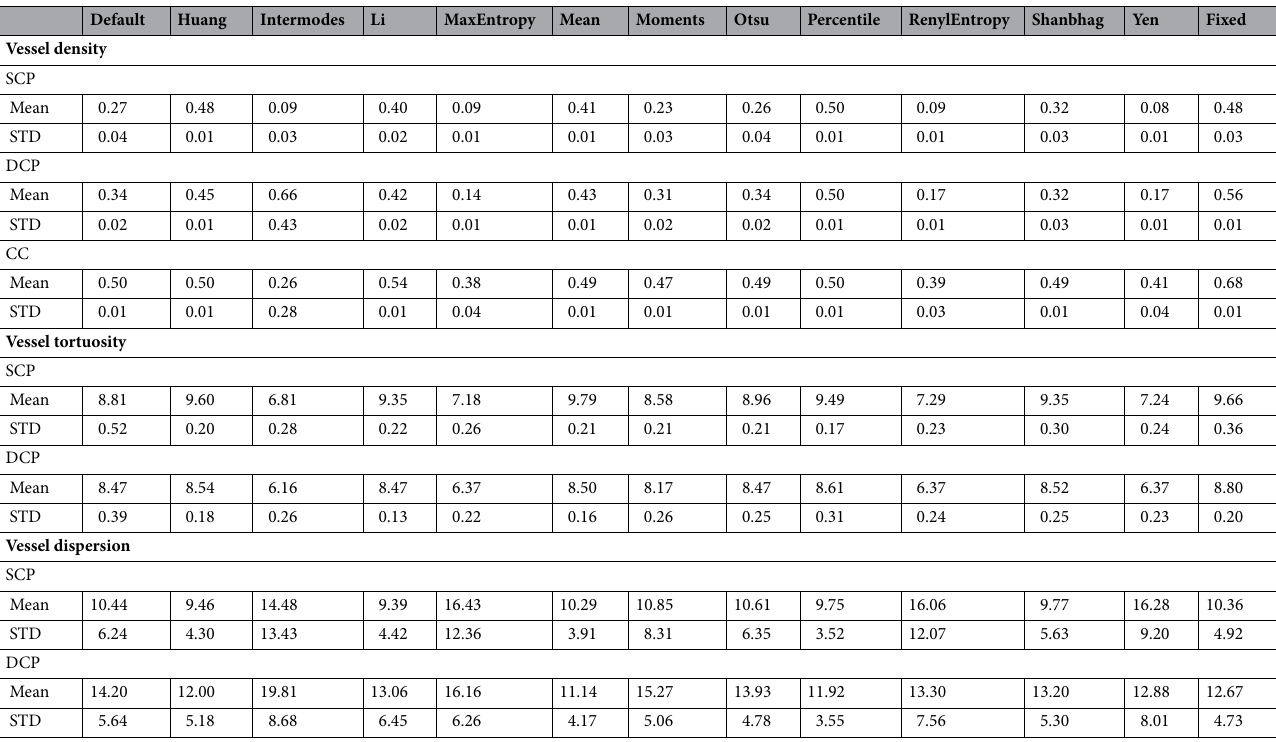
Table 3. Quantitative OCTA metrics measured for all binarized images.